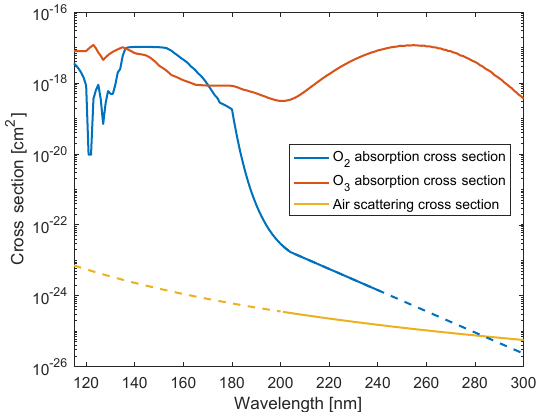
Figure 4. Comparison between the absorption cross section of O 2 and O 3 with the scattering cross section of air. Dashed lines show the interpolated